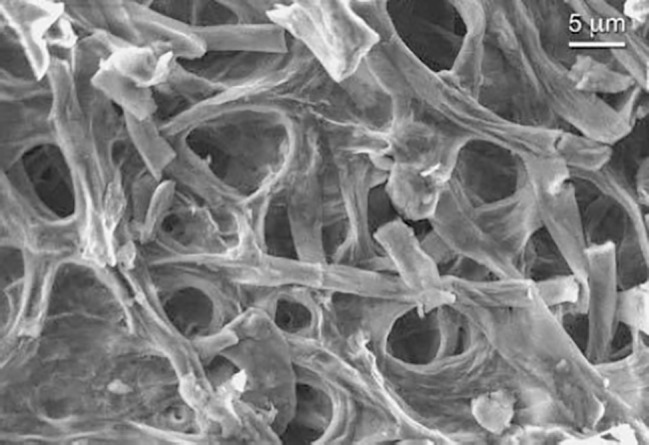
SEM secondary electron micrograph of P. eryngii mycelium.